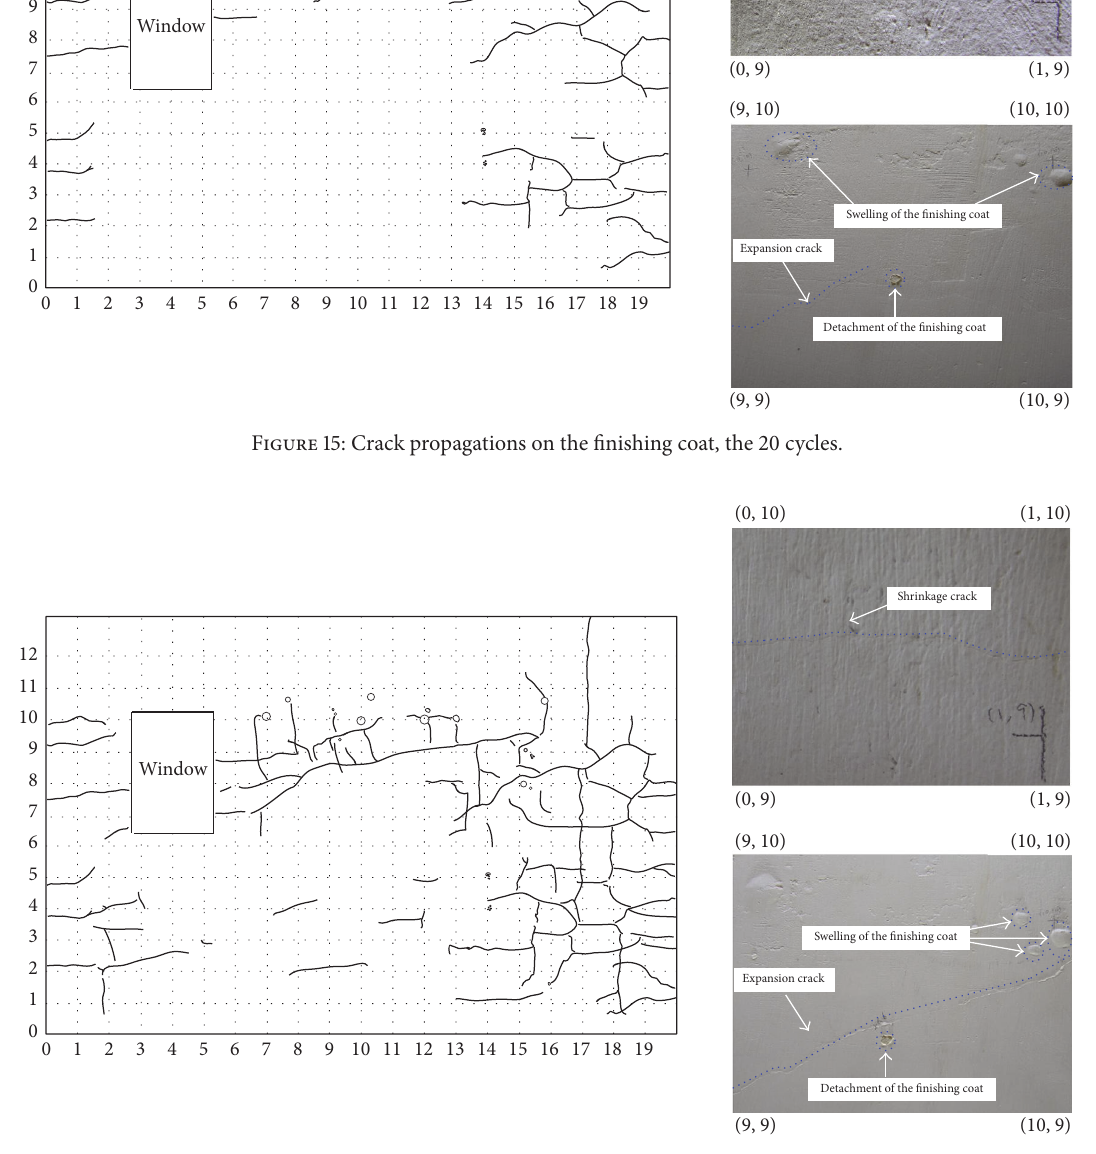
Figure 16: Crack propagations on the finishing coat, the 80